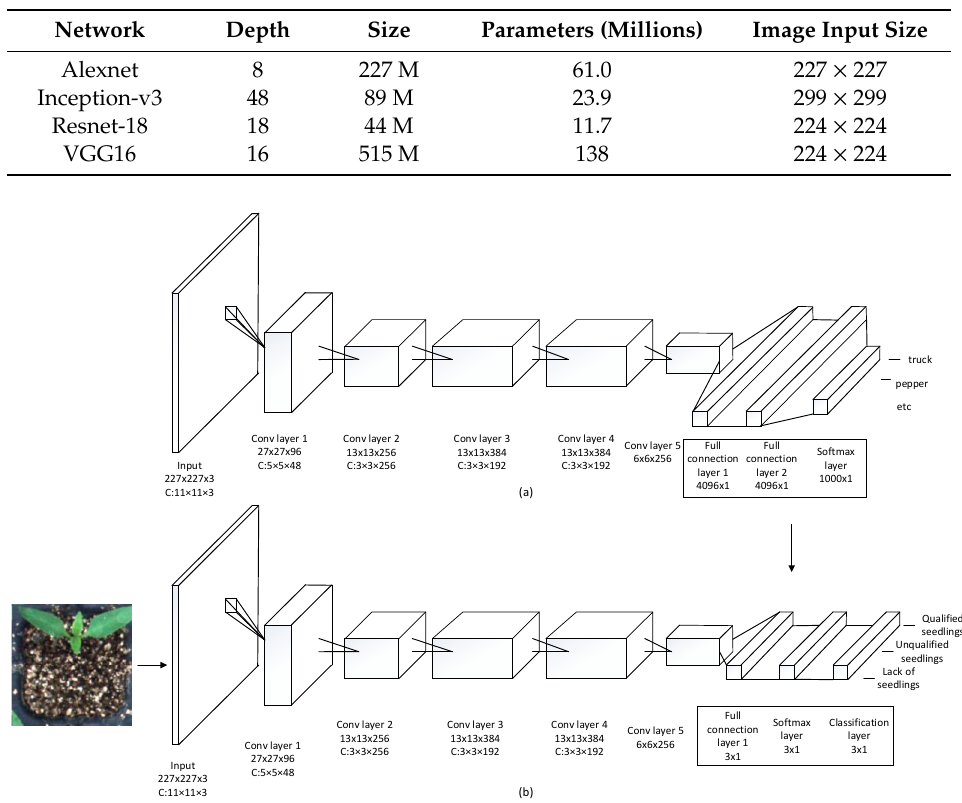
Table 2. Main parameters of 4 convolutional neural networks.